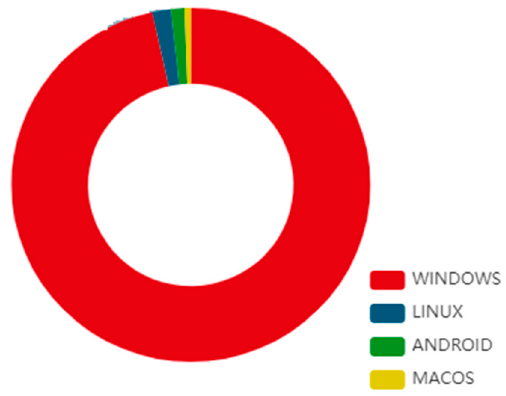
Figure 2. Classification of OS-based malware threats.